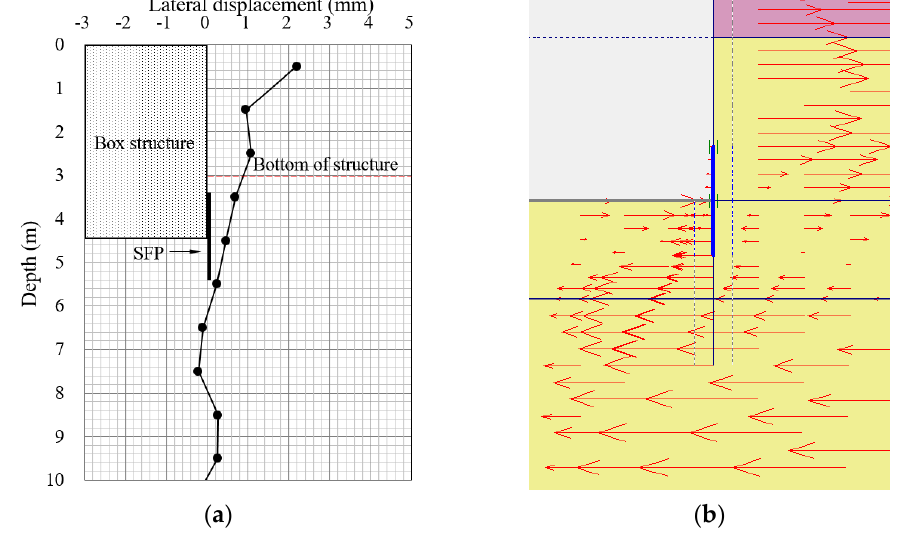
Figure 11. Visual analysis: ( a ) ground behavior; ( b ) SFP movement.